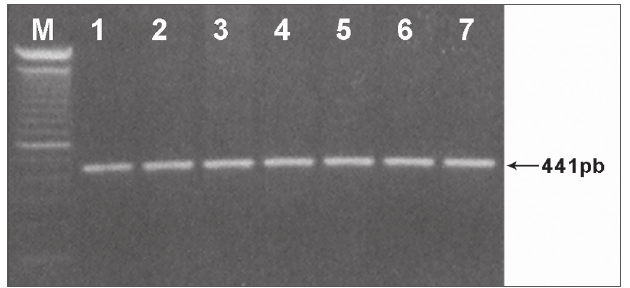
Figura 1. Fragmento de 441pb do gene 12S rRNA amplificado por